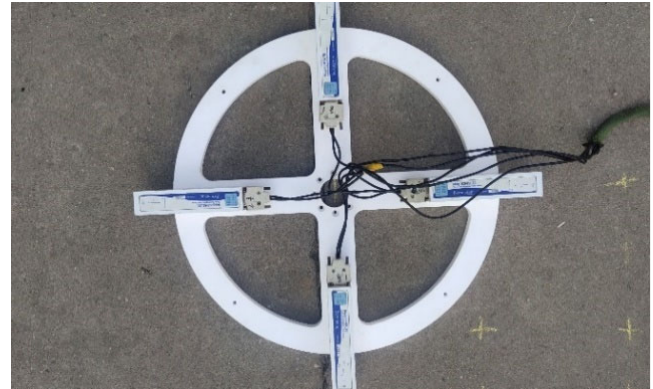
Figure 7. Magnetic gradient tensor detection device. When the magnetic anomaly source is detected, the sensor transmits the data to the data acquisition card through the data transmission line, and the data is processed by the information processing terminal. The results are obtained according to the corresponding algorithm. The flowchart is shown in the following figure. The experimental site is a cement road surface with complex magnetic interference. As in the simulation, we refer to Equation (8) as method 1 and Equation (9) as method 2, and the method proposed in this paper is called method